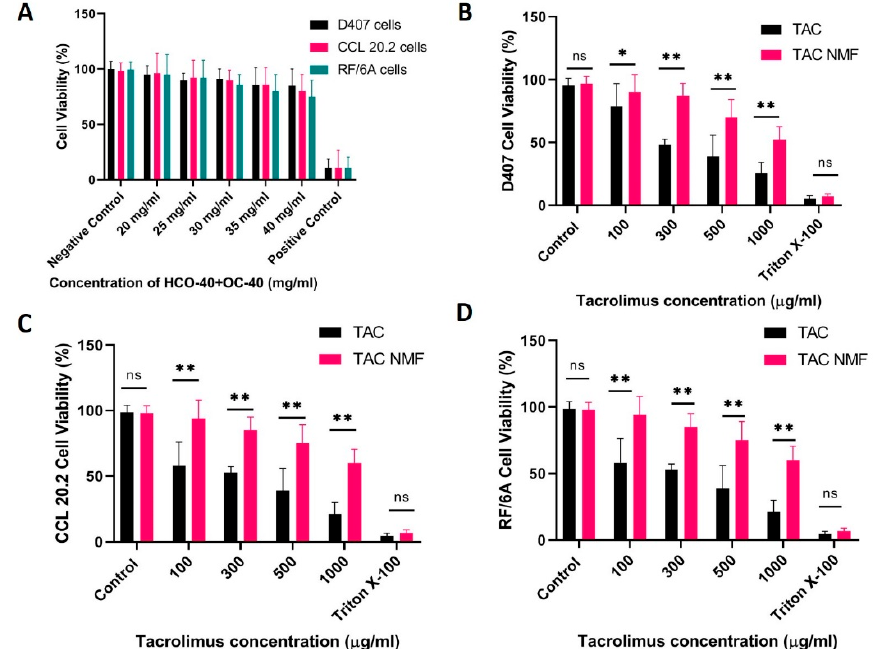
Figure 8. Cell viability determination by MTT assay. ( A ) Cell viability (%) of D407, CCL 20.2 and RF/6A cells after treatment with placebo NMF composed of mixture of HCO-40 and OC-40 amphiphilic polymers ranging from 20–40 mg/mL of total HCO-40 and OC-40 in a fixed ratio of (HCO-40:OC-40: 3.5:1) for 24 h. ( B ) Cell Viability (%) of retinal pigment epithelium cells (D407) after treatment with TAC and TAC-NMF for 24 h. ( C ) Cell Viability (%) of conjunctival cells (CCL 20.2) after treatment with TAC and TAC-NMF for 24 h. ( D ) Cell Viability (%) of choroidal endothelial cells (RF/6A) after treatment with TAC and TAC-NMF for 24 h. (* p ≤ 0.05 and ** p ≤ 0.01 as compared to the corresponding control group, here TAC).